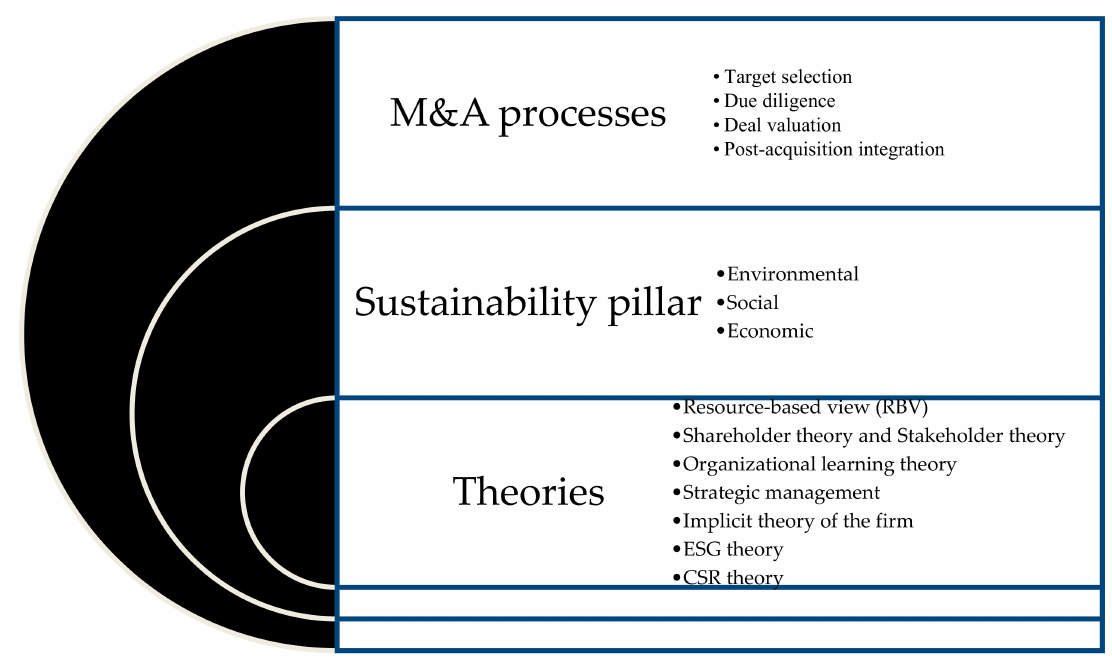
Figure 3. Sustainability framework for assessment of mergers and acquisitions in energy